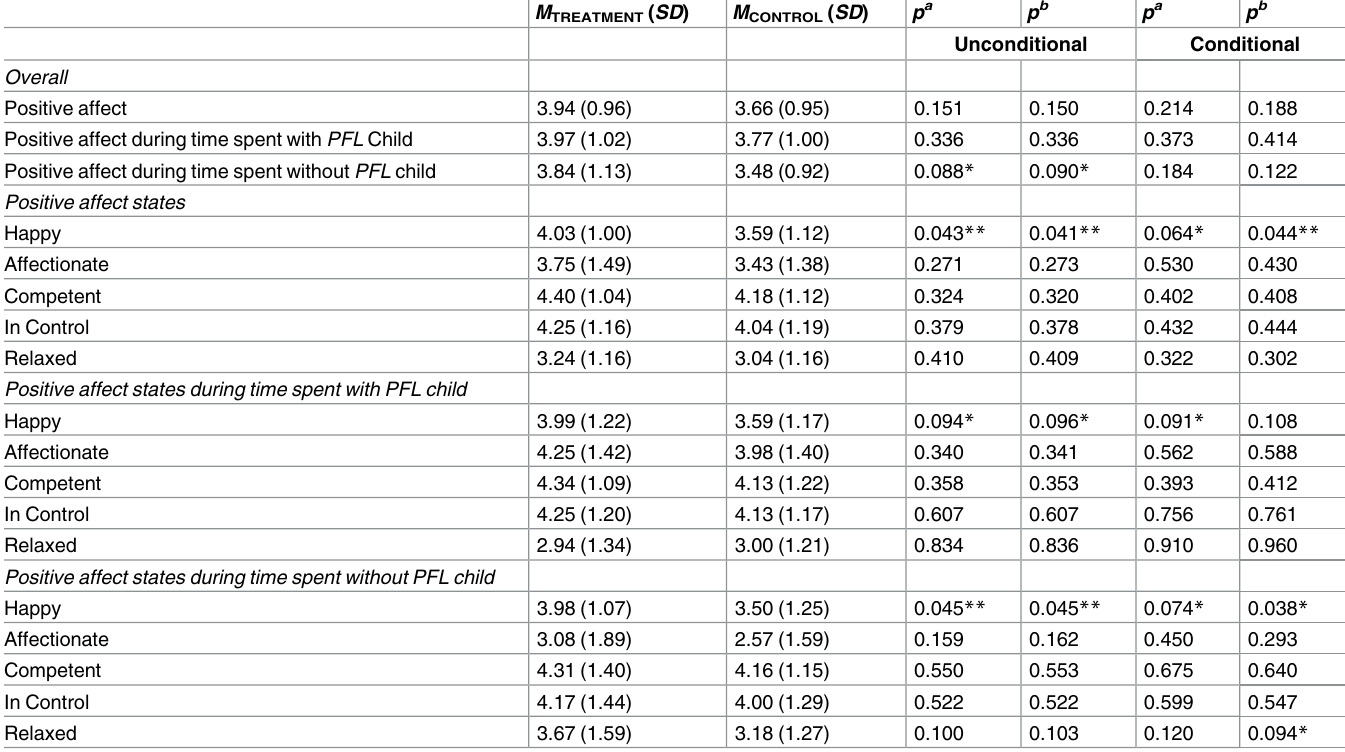
Table 2. Treatment Effects for Experienced Well-being: Positive